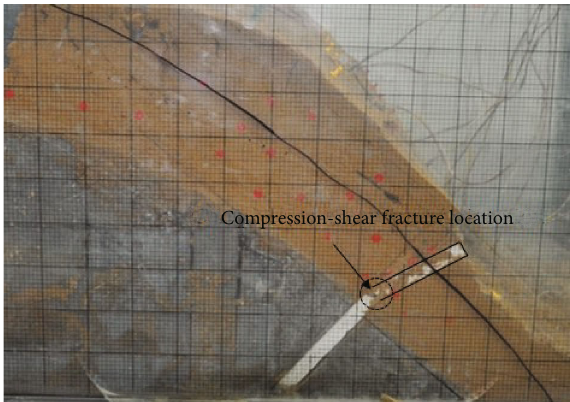
Figure 12: Fracture of the retaining wall locked segment.